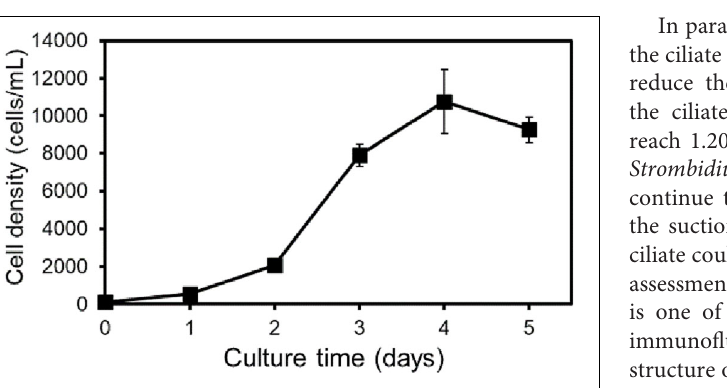
FIGURE 3 | Continuous culture of Strombidium sp. NTOU1 with frozen Erwinia spp. A continuous culture was carried out by adding 10,000 times the ciliate number of frozen Erwinia spp. as a food source with an initial ciliate density of 100 cells/mL. The error bar represents the SD of the average from three independent